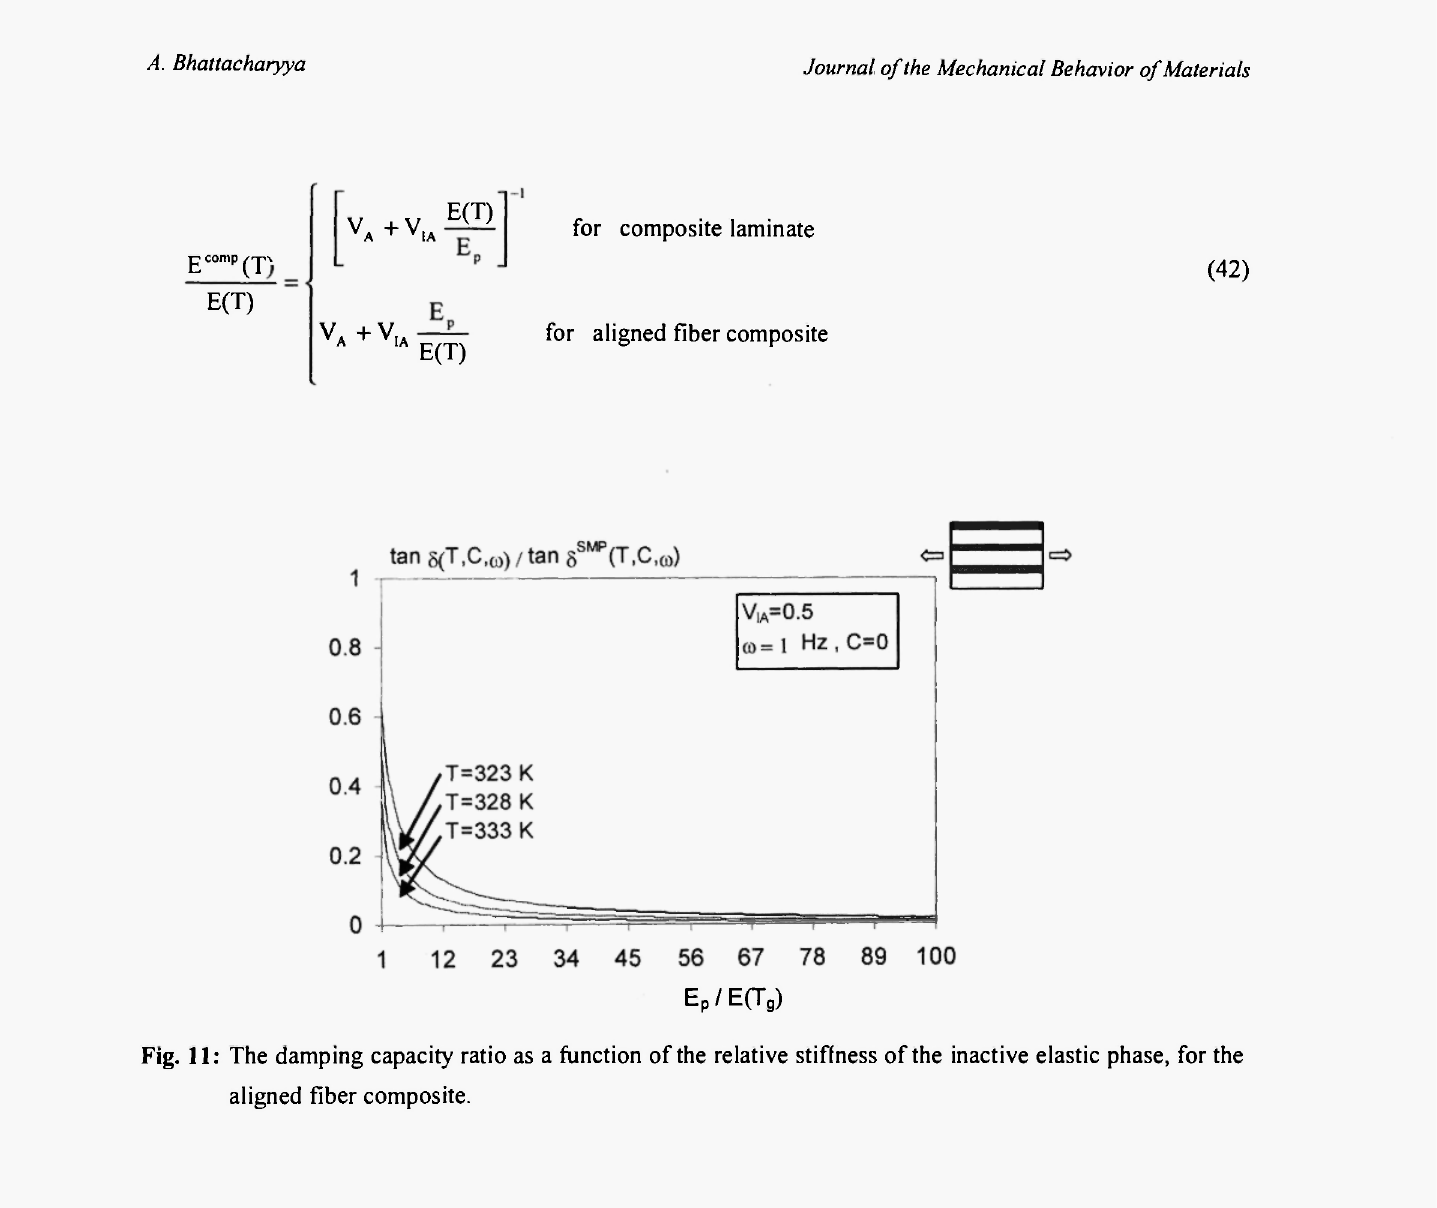
Fig. 11: The damping capacity ratio as a function of the relative stiffness of the inactive elastic phase, for the aligned fiber